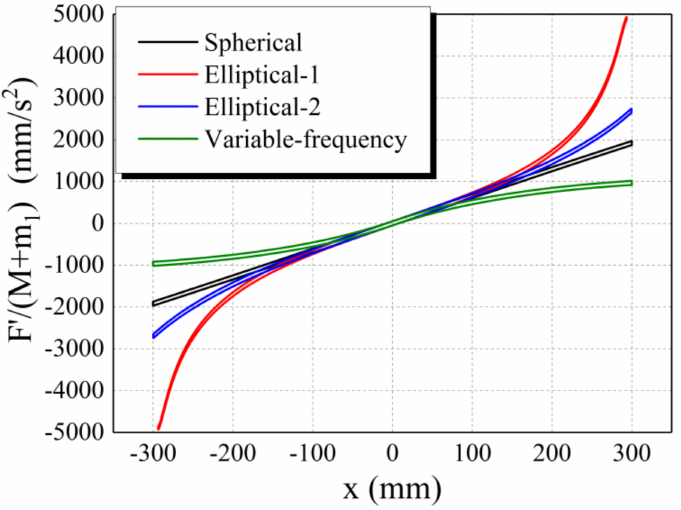
Figure 6. Theoretical hysteretic curve